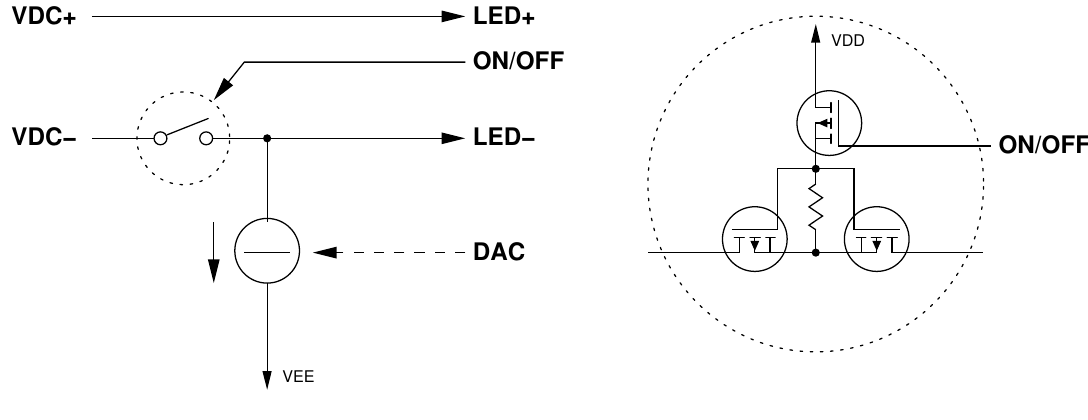
Figure 5. Details of the modulator